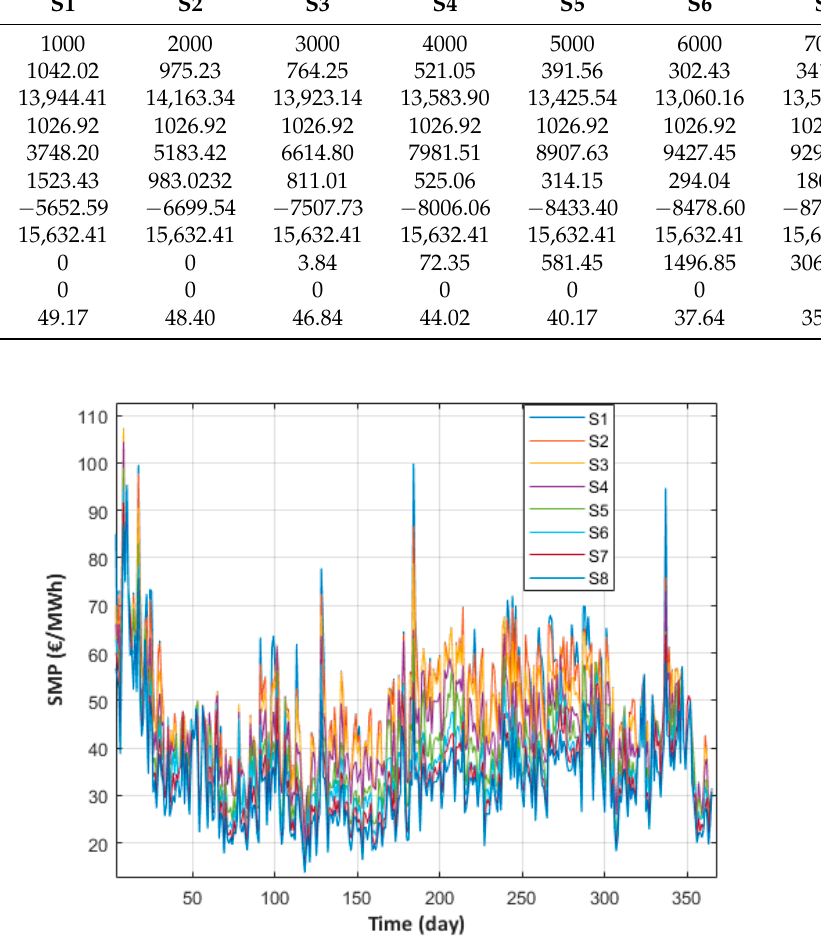
Figure 2. Daily average system marginal price (SMP) series per scenario. (source: Authors).